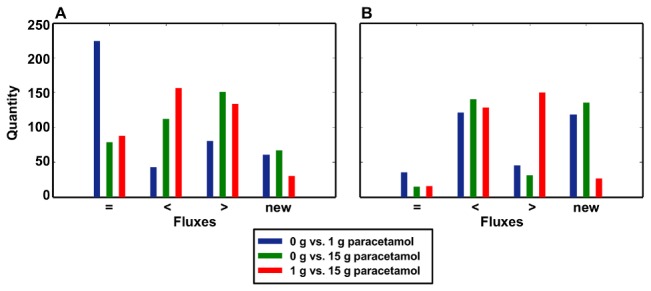
Comparison of two specific liver functions (production of oleate and cysteine, respectively).Only fluxes which are nonzero at least in one of the three cases are compared. The number of fluxes which remain at their original values ( = ), become smaller or higher (<, >) or are non-zero (new) after application of 1 g and 15 g of paracetamol are indicated.. (A) Changes in fluxes after application of 1 g and 15 g paracetamol for production of oleate. (B) Changes in fluxes after application of 1 g and 15 g paracetamol for production of cysteine.